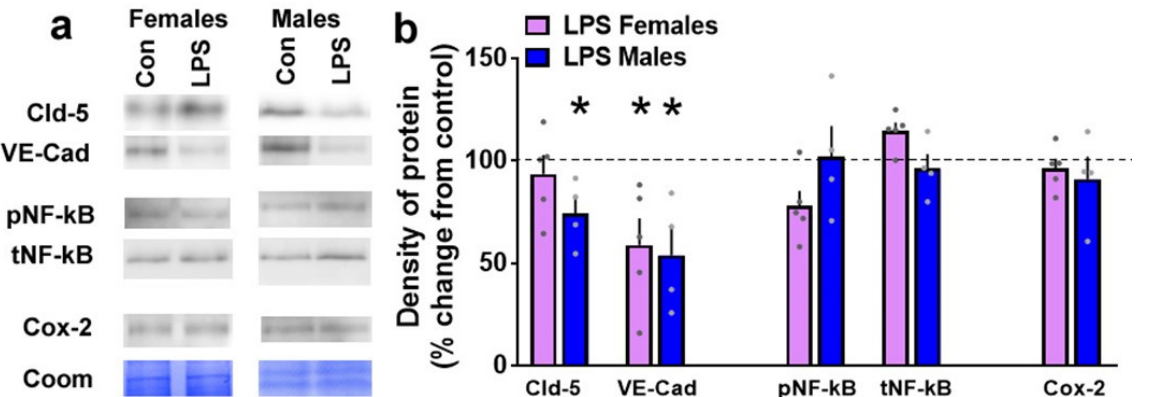
Figure 8. Western blotting analysis of tight junction proteins and neuroinflammatory markers in the prefrontal cortex (PFC) of female and male rats that were exposed to saline or LPS challenges. Representative immunoblots with corresponding Coomassie (Coom) blot is indicated in ( a ). Coom band 150 kDa was used for female samples and band 250/150 kDa was used for male samples. Claudin-5, Cld-5; VE-Cadherin, VE-Cad; phospho NF-kB, pNF-kB; total NF-kB, tNF-kB; control, con. ( b ) Quantitative data represented as mean ± S.E.M. of percent change in density of protein from respective controls (indicated as dashed line). n = 4 control female, n = 5 LPS female, n = 3 control male, n = 4 LPS male. * p < 0.05 between saline and LPS within each sex.